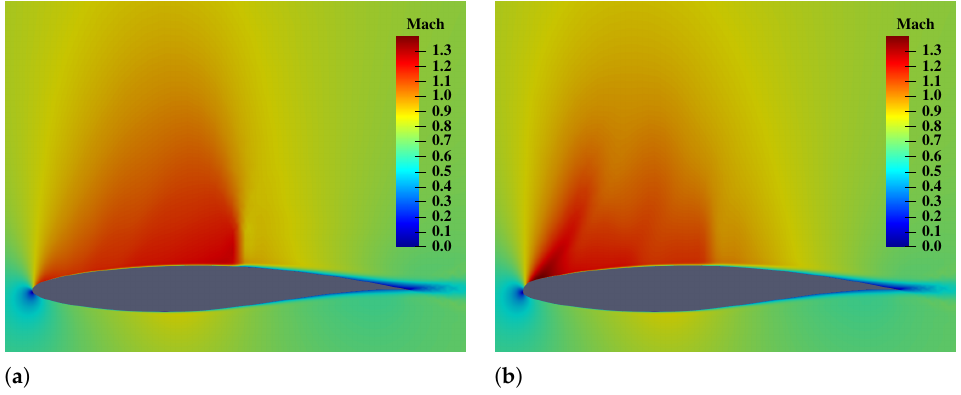
Figure 9. Mach contours for baseline and optimized RAE 2822 by using a morphing leading edge. ( a ) Baseline airfoil. ( b ) Optimized airfoil with a morphing leading